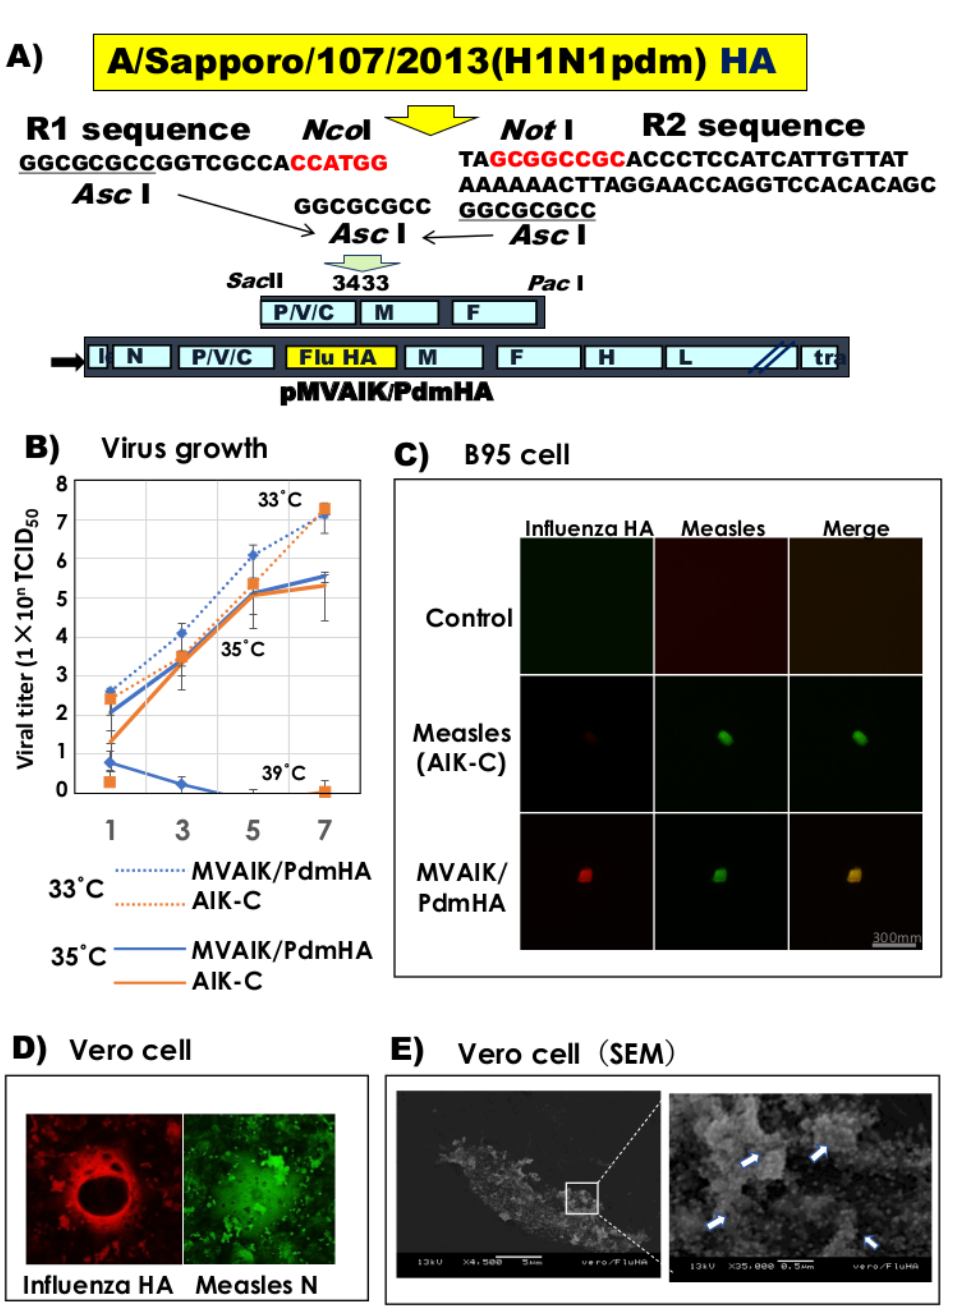
Figure 2. Construction of recombinant measles AIK-C expressing influenza HA protein. ( A ) The HA gene was cloned from influenza virus A/Sapporo / 107/2013(H1N1pdm) HA and inserted at the P/M junction of the infectious cDNA. ( B ) Vero cells were infected with MVAIK/PdmHA at different temperatures (33 °C, 35 °C, and 39 °C) and culture fluids were obtained on days 1, 3, 5, and 7 of culture to examine the infectivity. Vertical lines represent mean ± SE. ( C ) Live staining of the cell surface expression of measles and influenza HA proteins on B95 cells. ( D ) Vero cells were infected with MVAIK / PdmHA using monoclonal antibodies against influenza HA and measles N proteins. ( E ) Electron microscope findings of the expression of influenza HA protein. Square region in the left panel is magnified, with white arrows showing the binding of Au colloids.